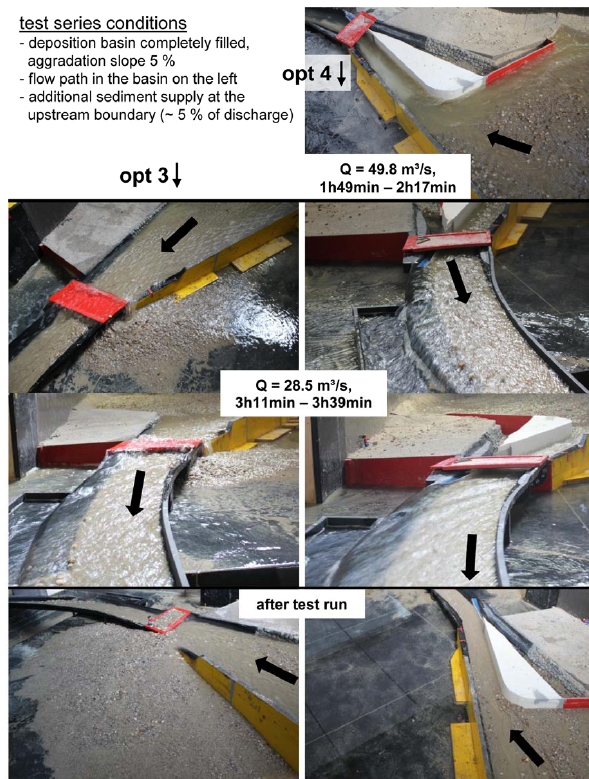
Fig. 7. Results from experimental modelling for the “opt 3” and “opt 4” design layouts (Fig. 4) – situation in the near range of the bridge during and at the end of the flood hydrograph (Fig. 2).